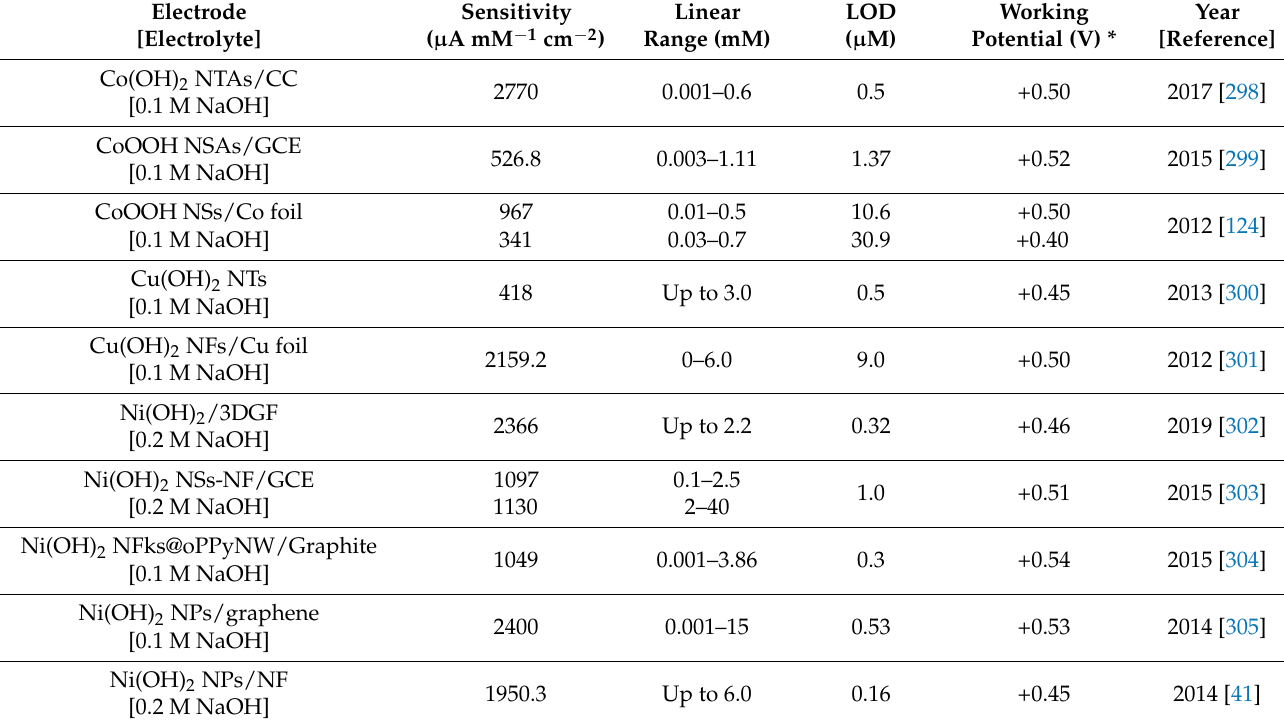
Table 6. The electrodes for the sensing of glucose by the transition metal hydroxides. The performances are compared in terms of sensitivity, linear range, limit of detection (LOD), and working potential. The working potentials are based on the reference electrode of